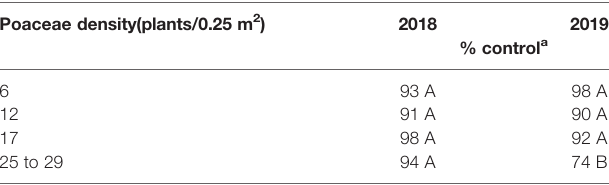
TABLE 8 | Poaceae control 21 DAT as in fl uenced by Poaceae density. Poaceae density(plants/0.25 m 2 )